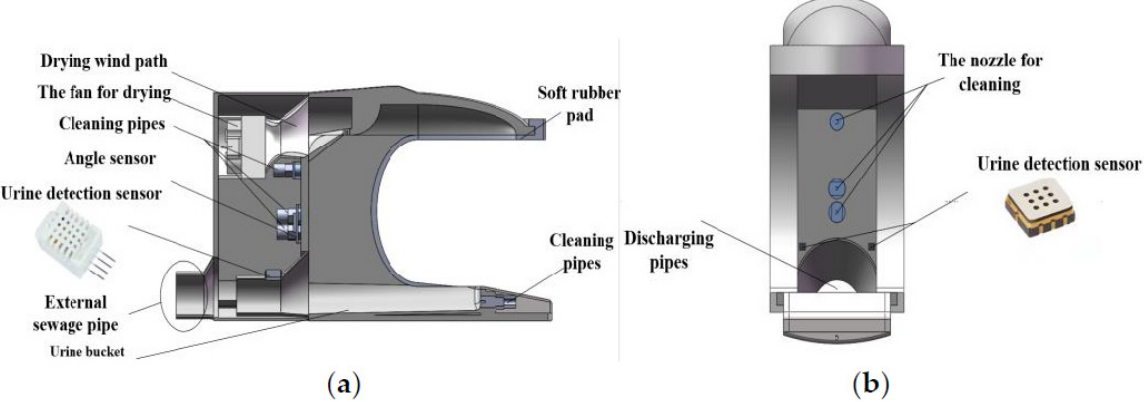
Figure 3. Mechanical structure of the working head. ( a ) Side view; ( b ) Front side view.